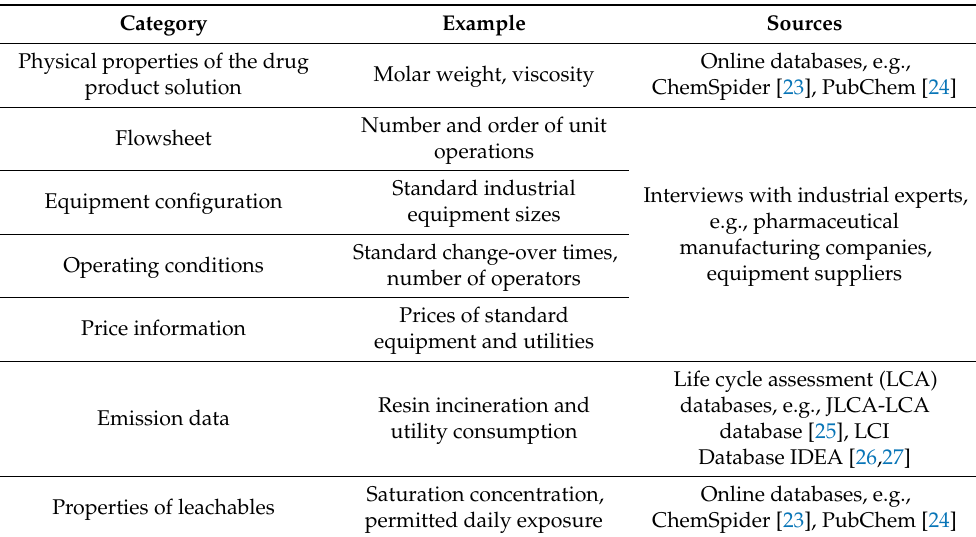
Table 2. Database parameters and their